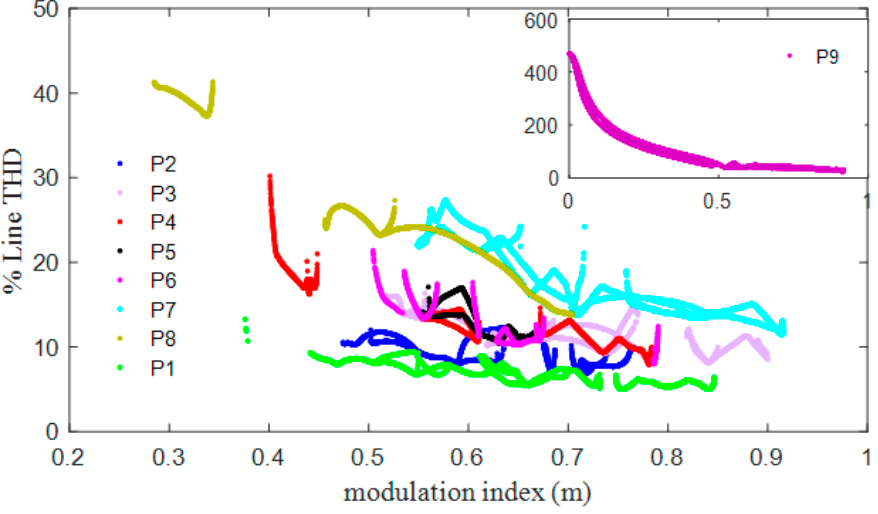
Figure 6. % Line THD for the entire pattern as a function of modulation index M .